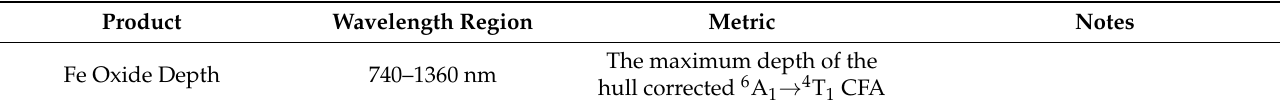
Table 2. The spectral metrics used in the formation of the iron boomerang and the subsequent mixing ratio